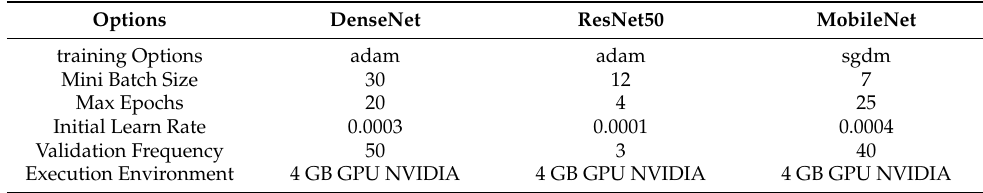
Table 2. Adjust hyperparameters options for DenseNet121, ResNet50, and MobileNet models.